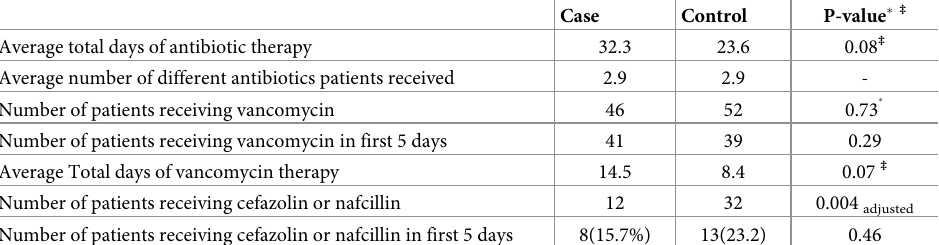
Table 5. Antibiotics given by Case/Control status � .